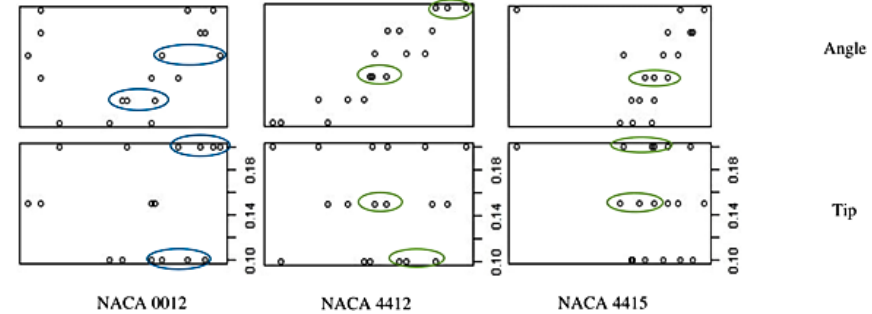
Figure 20. Normal force scatter plot for blade angle and blade tip size of airfoils NACA 0012, NACA 4412, and NACA